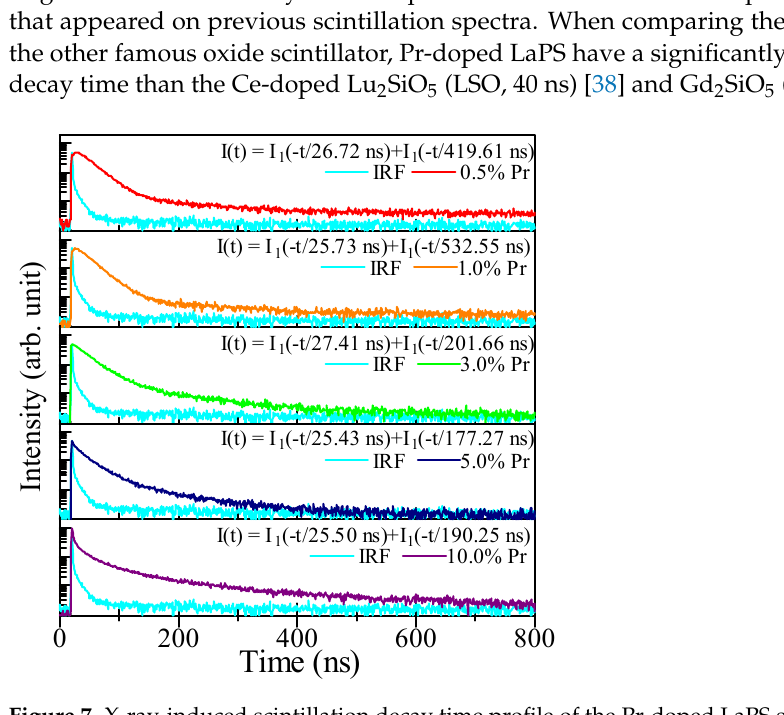
Figure 7. X-ray-induced scintillation decay time profile of the Pr-doped LaPS samples.